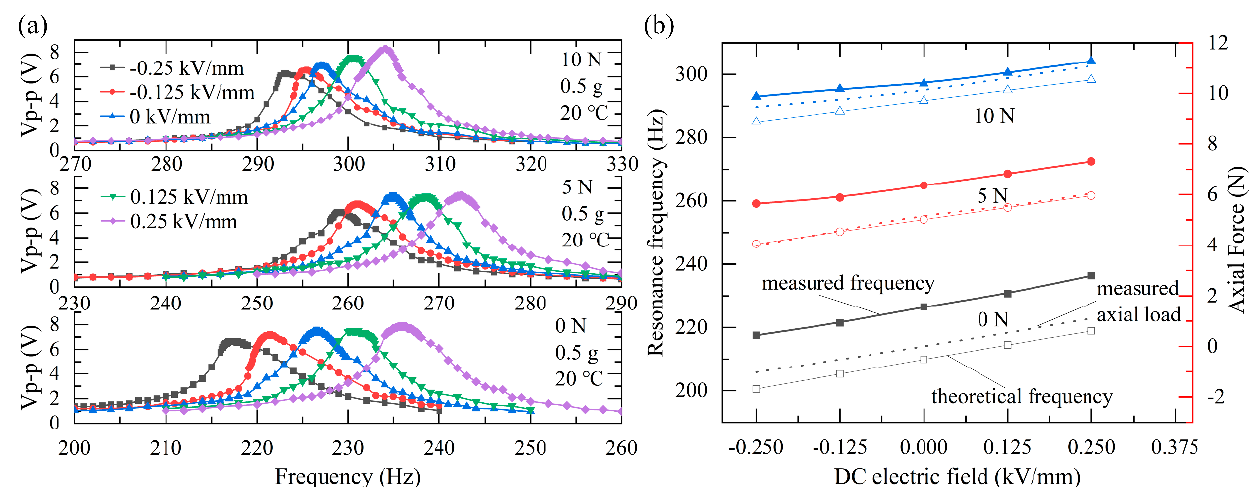
Figure 3. ( a ) The output voltage as a function of frequency under different DC electric fields and axial preload; ( b ) The measured resonance frequency, the measured axial preload, and the theoretical resonance frequency under different DC electric fields and different preloads.